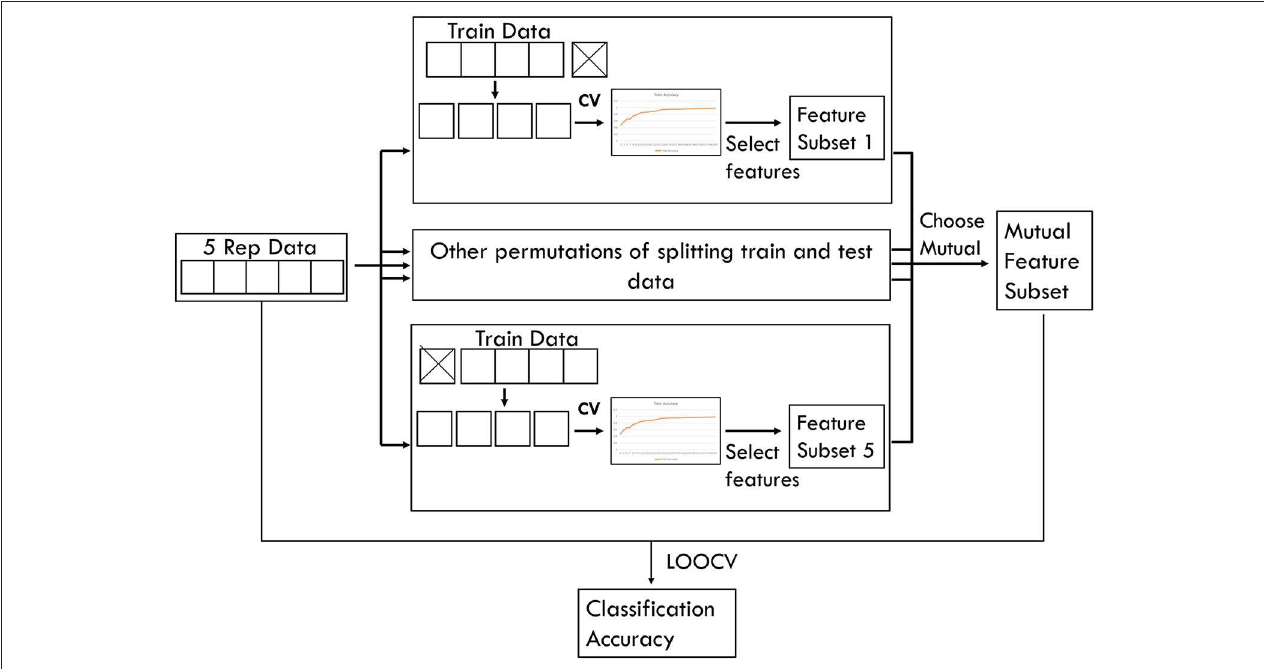
FIGURE 5 | Feature selection process used in this